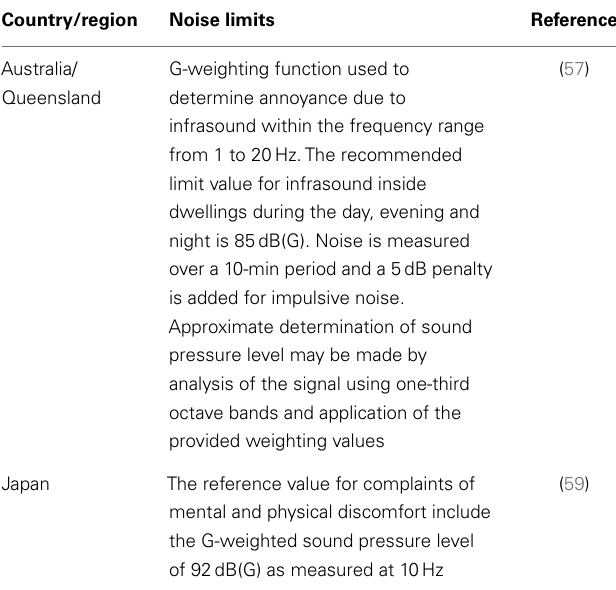
Table 5 | Infrasound noise limits per jurisdiction (not wind turbine specific)